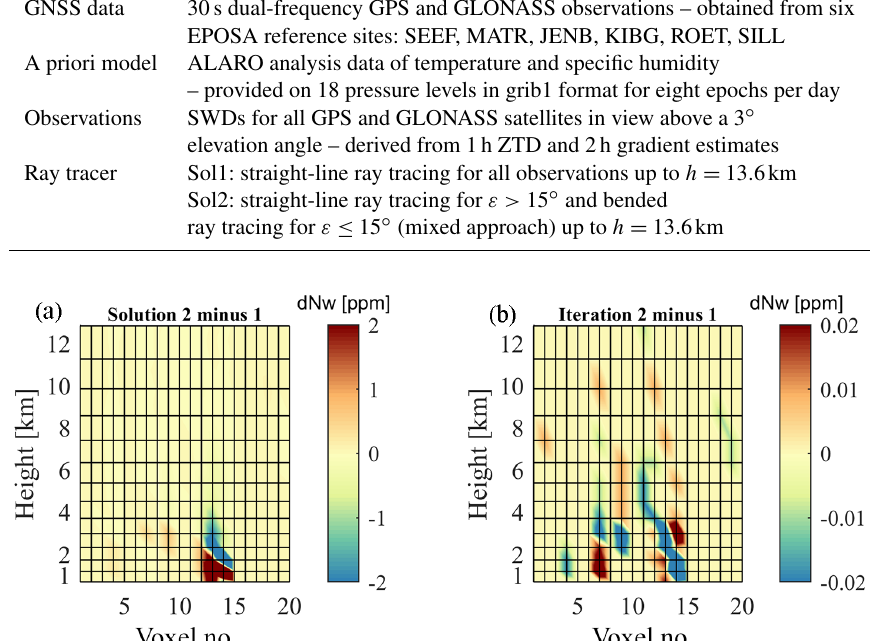
Figure 7. Error in wet refractivity caused by the straight-line assumption (a) and the differences in wet refractivity between first and second iterations (b) . Here, voxel number 1 is dedicated to the southwest corner and number 20 to the northeast corner of the voxel model. For visualization, a bilinear interpolation method was applied between the grid points. Analyzed period: 4 May 2013 at